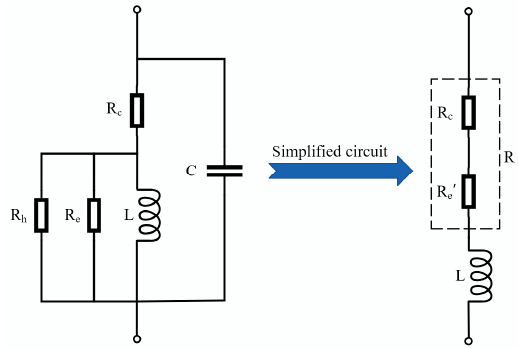
Figure 4. Simplified model of the inductance coil.